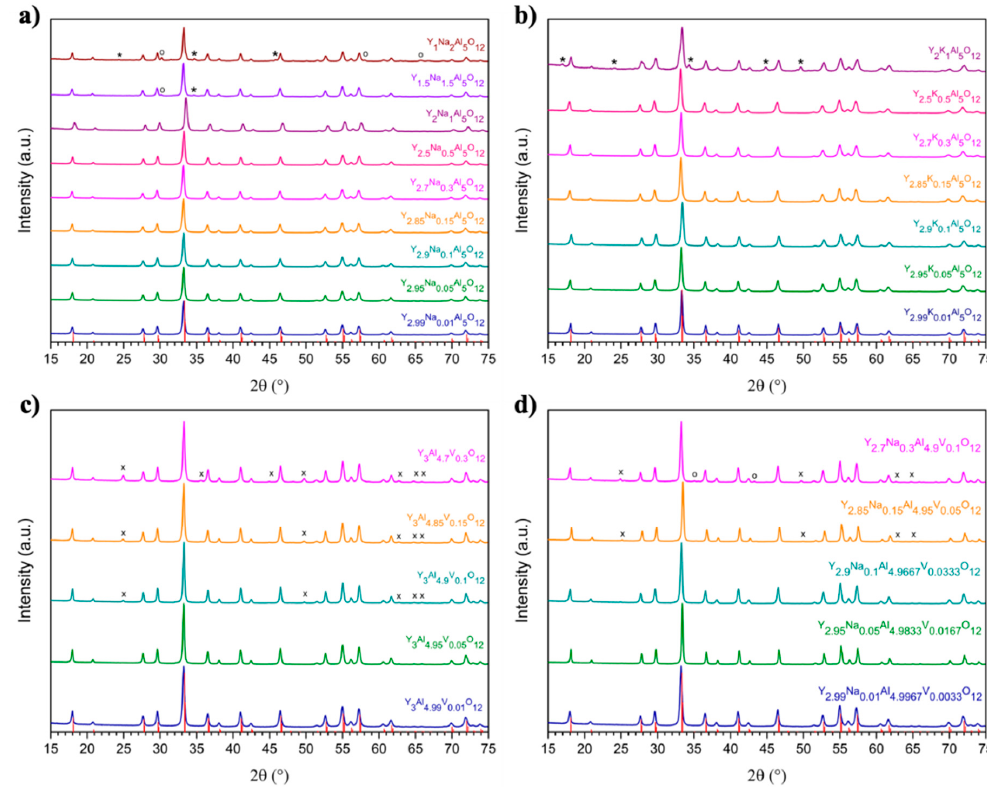
Figure 1. XRD diffraction patterns of Y 3 − x Na x Al 5 O 12 ( a ), Y 3 − x K x Al 5 O 12 ( b ), Y 3 Al 5 − y V y O 12 ( c ) and Y 3 − x Na x Al 5 − y V y O 12 ( d ) samples synthesized at 1000 °C. The crystalline phases are marked: * - YAlO 3 [PDF #96-153-3070], o - Al 2 O 3 [PDF #96-100-0443], x - YVO 4 [PDF #96-901-1138]. Vertical red lines – standard Y 3 Al 5 O 12 [PDF #96-152-9038]. The XRD patterns of the Y 3 Al 5 − y V y O 12 samples heated at 1000 °C with the different